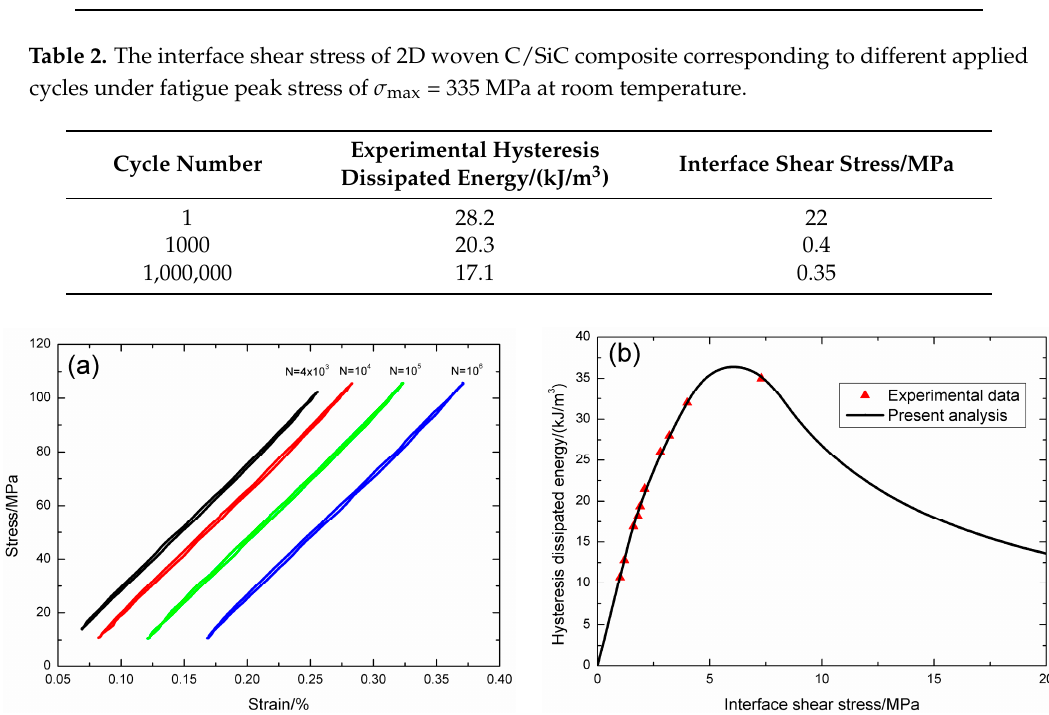
Figure 6. ( a ) The experimental fatigue hysteresis loops corresponding to different cycle number; and ( b ) the experimental and theoretical fatigue hysteresis dissipated energy versus interface shear stress curve of cross-ply C/SiC composite under σ max = 105 MPa at room temperature.